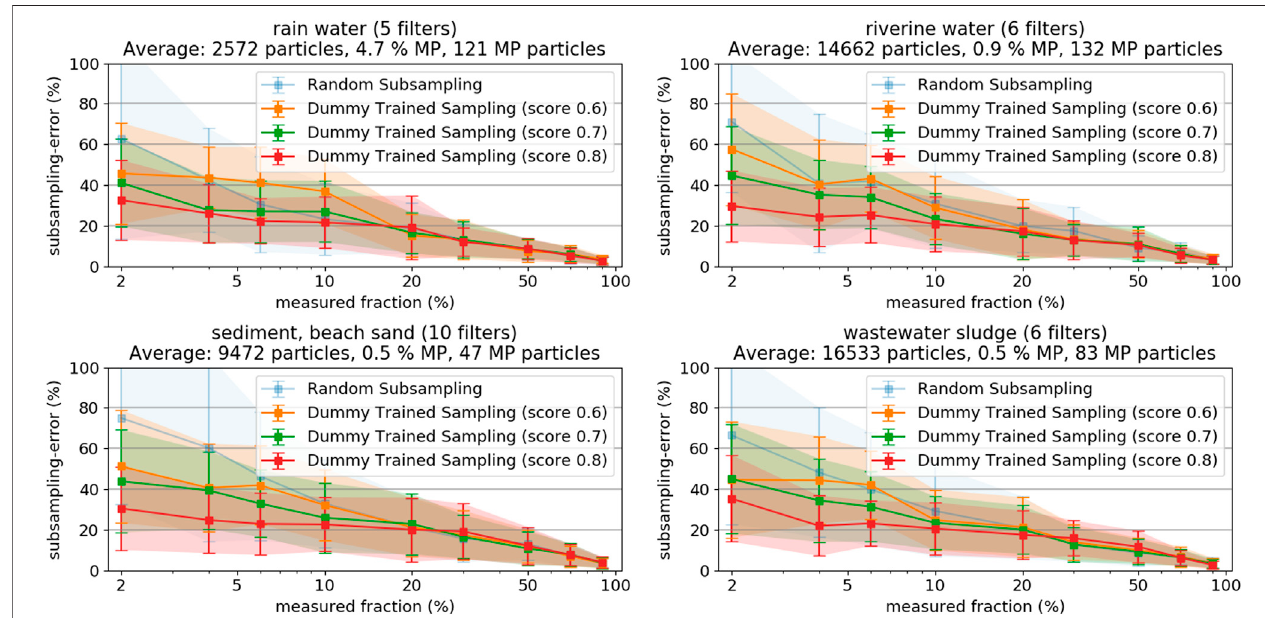
FIGURE 6 | Resulting subsampling-errors and their standard deviation from random sampling based on trained classi fi ers with different scoring, as derived from samples from rainwater, river water, sediment, and sludge, respectively.